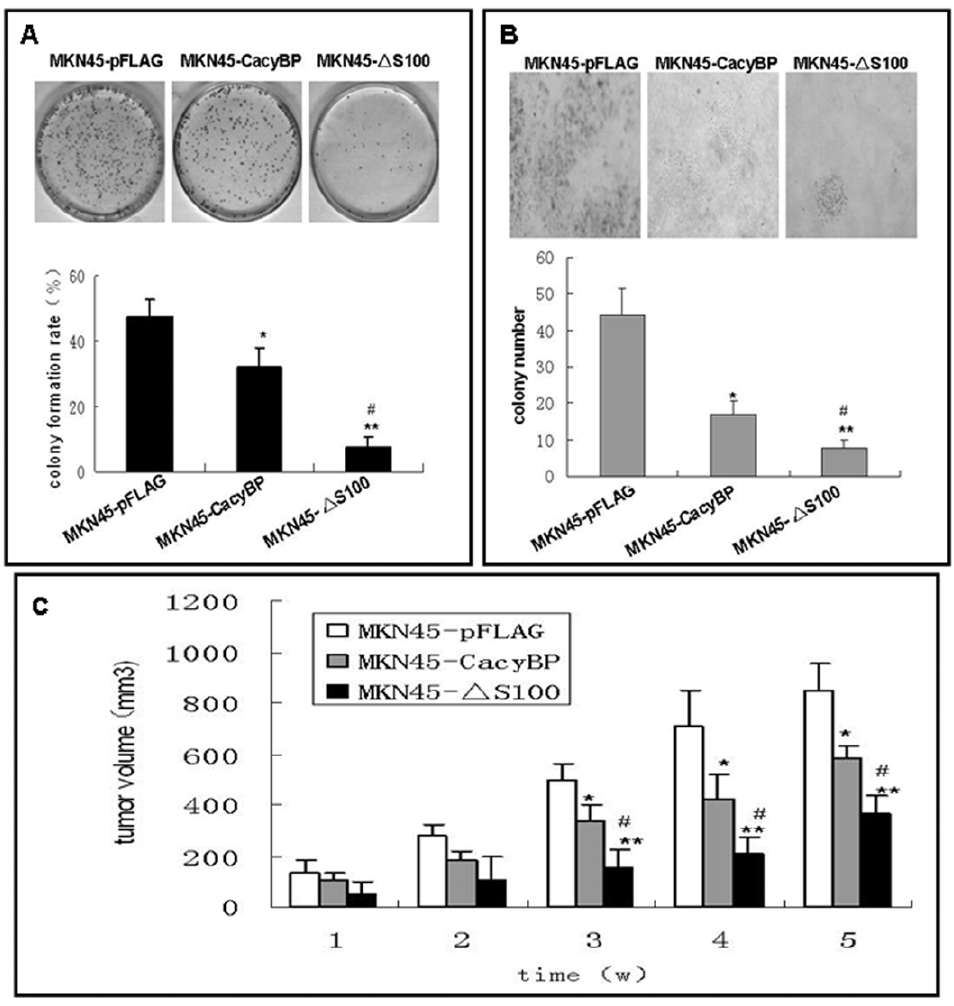
Figure 4. Effects of CacyBP/SIP transfectants on tumorigenesis. (A) Detection of the clonogenic formation in medium. (B) Detection of the clonogenic formation in soft agar. Cells were placed in media containing soft agar or on a plate and incubated for 20 days. The number of foci . 100 m m was counted. Vertical bars represent the mean 6 SD from at least three separate experiments, each conducted in triplicate. (C) In vivo tumorigenicity was evaluated by a nude mice assay. Mice were injected subcutaneously with 1 6 10 7 transfected cells. The volume of each tumor was calculated according to the formula 0.5 6 length 6 width 2 . Two independent experiments were performed and each experimental group consisted of five mice. * P , 0.05 vs. MKN45-pFLAG, ** P , 0.01 vs. MKN45-pFLAG, # P , 0.05 vs.